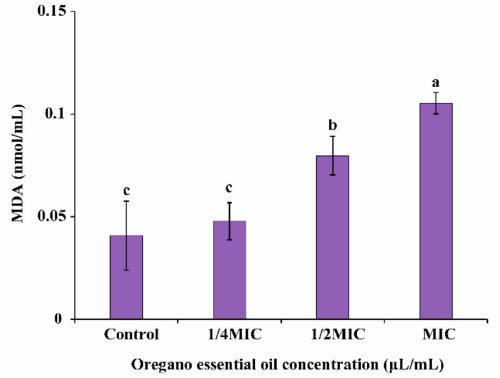
Figure 6. Extracellular malondialdehyde (MDA) in E. faecalis ATCC 29212 treated with OEO. Different lowercase letters indicate statistically significant differences between the means ( p <